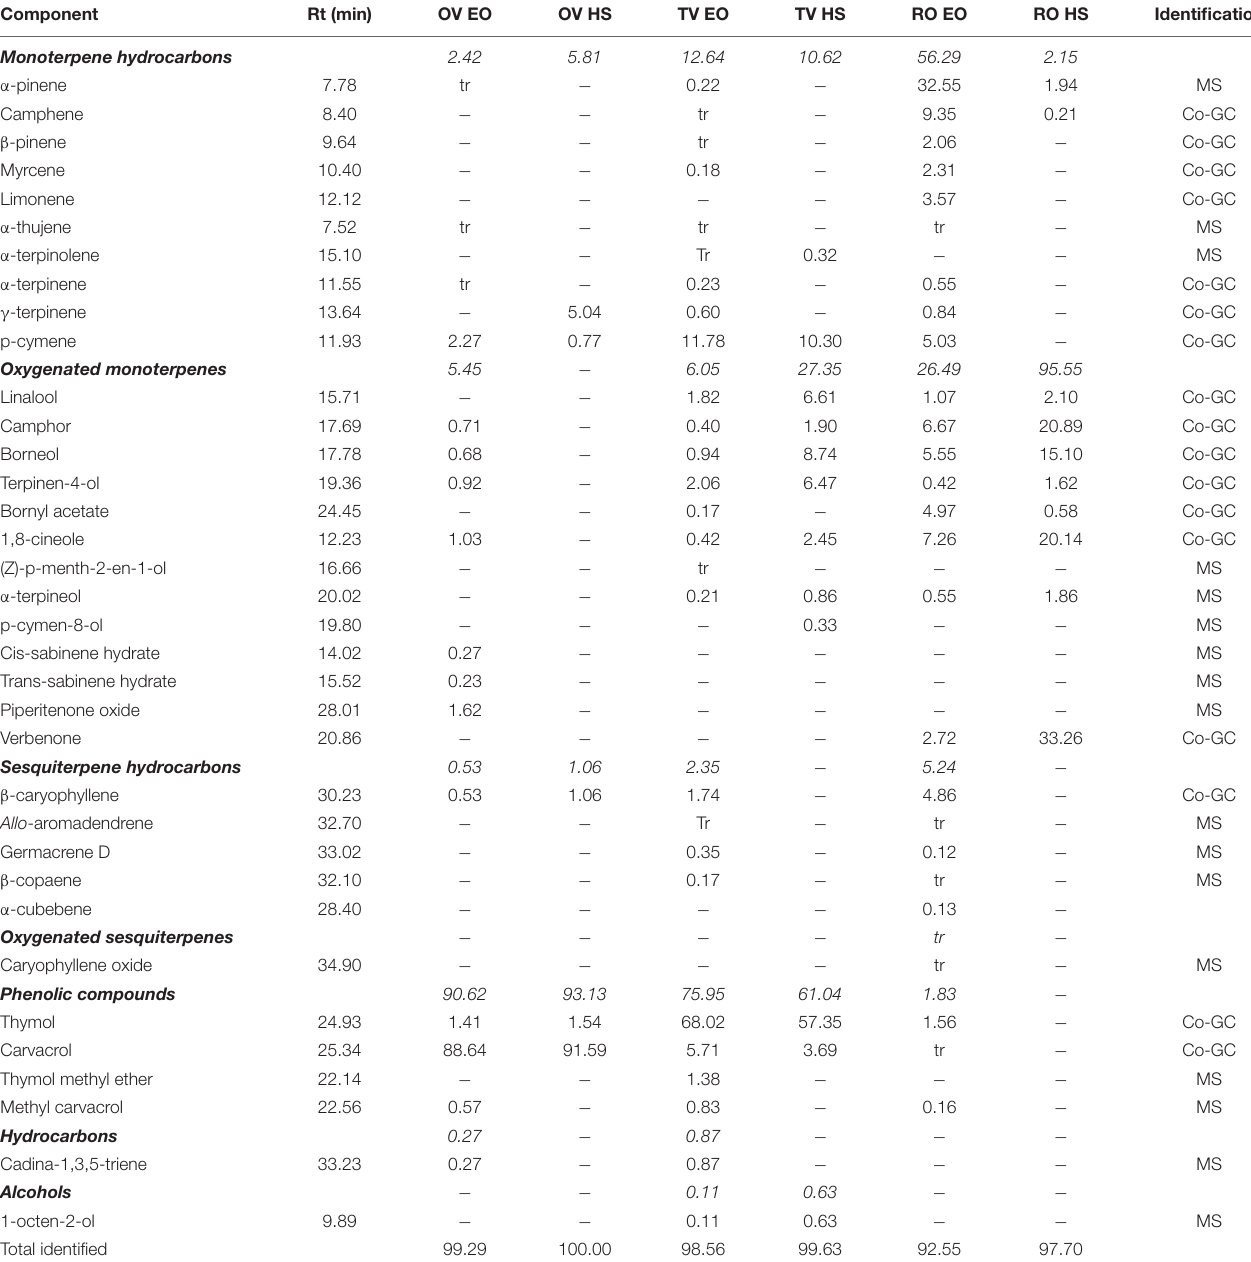
TABLE 1 | Phytochemical composition (%) of essential oils (EOs) and hydrosols (HSs) used in this study, by GC-MS.